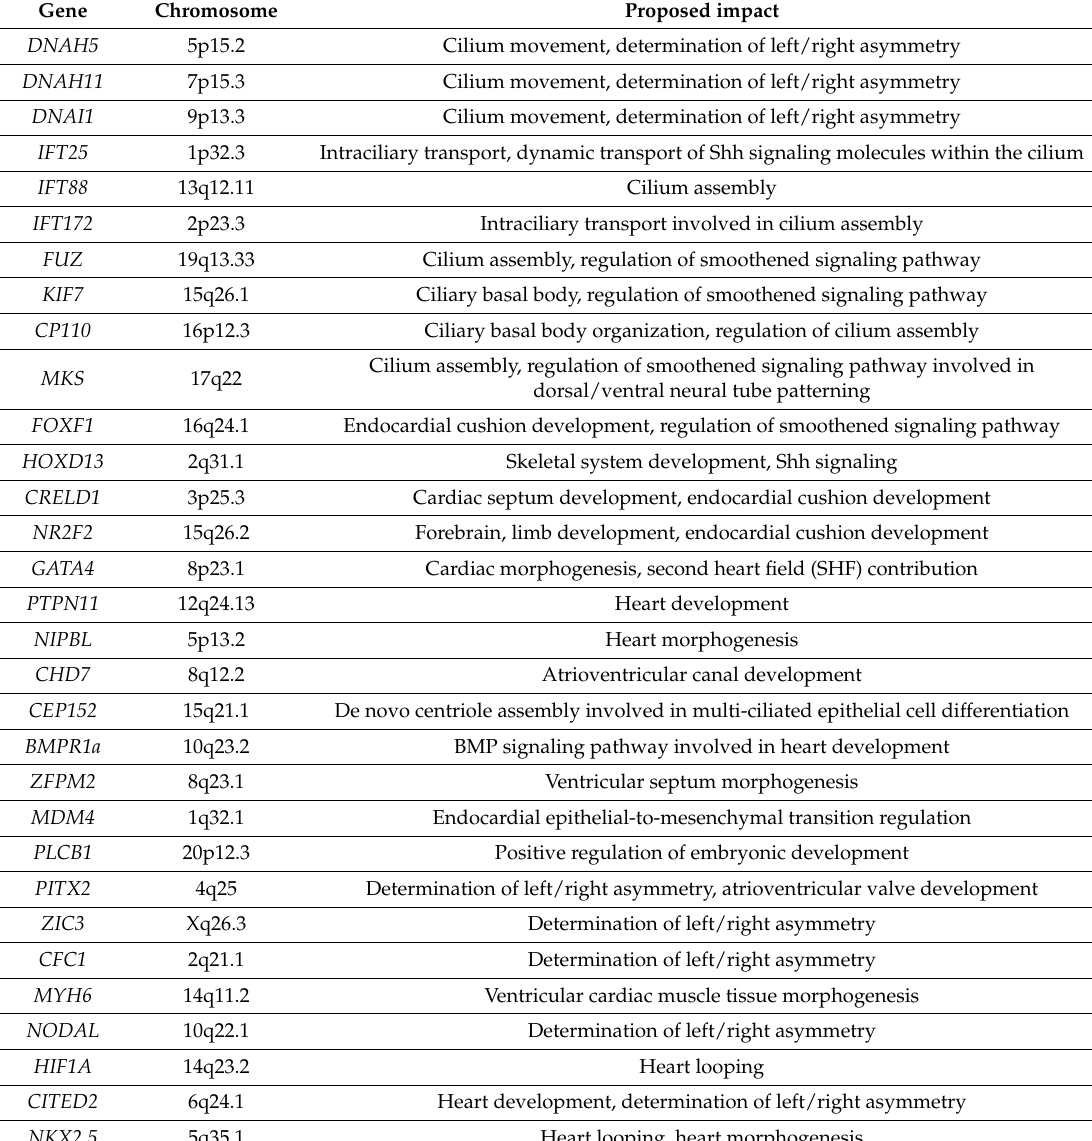
Table 2. Genes involved in the development of atrioventricular canal defect (AVCD) and transposition of the great arteries